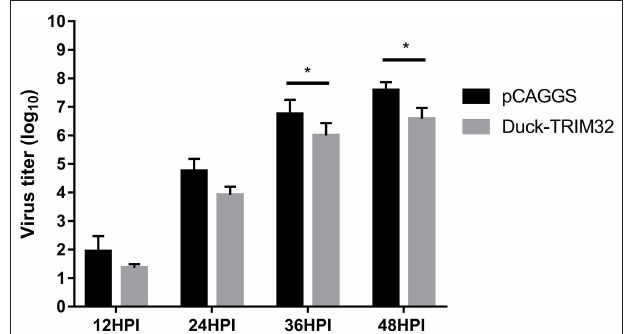
FIGURE 10 | DuTRIM32 inhibits the replication of H5N6 HPAIV in DEFs. The DEFs (12 wells) were transfected with either the pCAGGS-duTRIM32-V5 (1 µ g/well) or the empty vector (1 µ g/well). At 24h post-transfection, the transfected cells were infected with DK16873 H5N6 HPAIVs (5 TCID 50 ). Cell supernatants were collected at 12, 24, 36, and 48h post-infection and analyzed for their TCID 50 titers in DEFs. Virus titers are expressed as means ± standard deviation in log 10 TCID 50 /mL, and the Student’s t -test was used to analyze the differences. (* p <